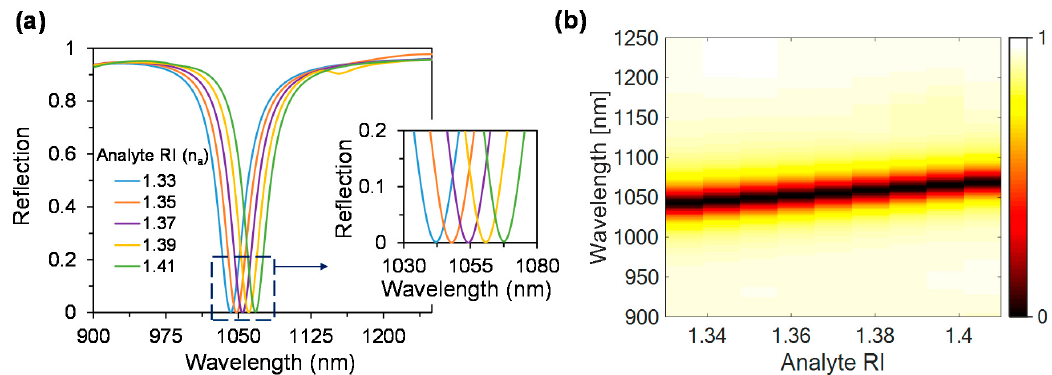
Figure 7. ( a ) Reflection spectra with varying the analyte RI from 1.33 to 1.41, and ( b ) Reflection intensity as a function of analyte RI.